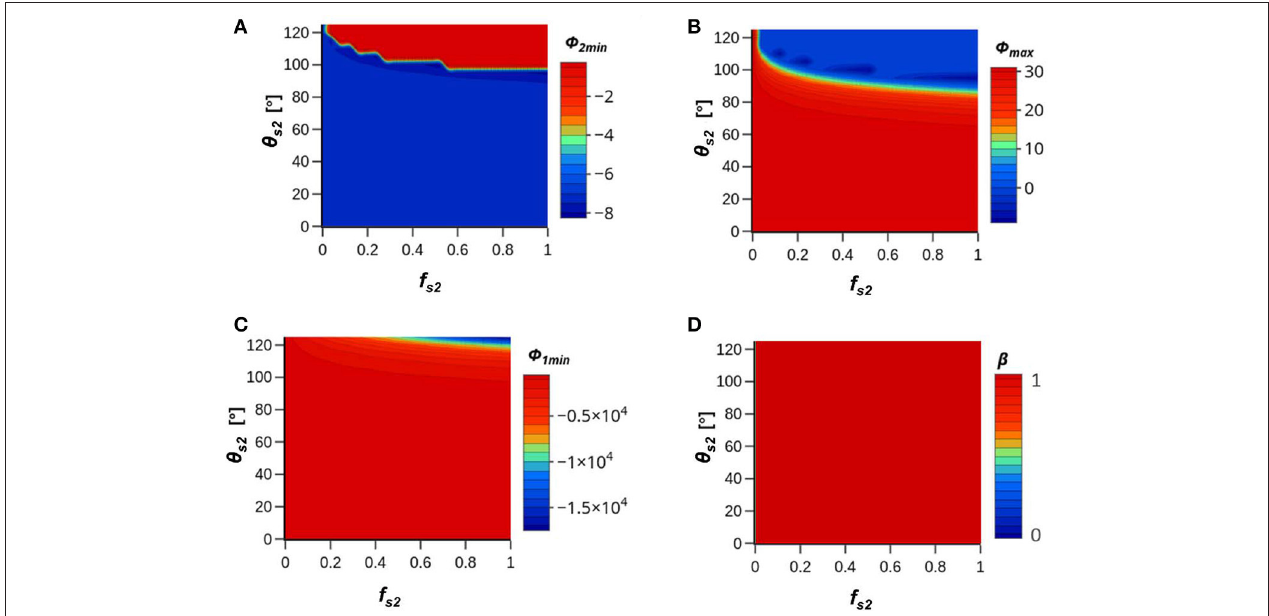
50mM NaCl and heterogeneity in Lewis acid-base = 0 to 125 ◦ and f s 2 0 to 1, and values of θ s 1 = =